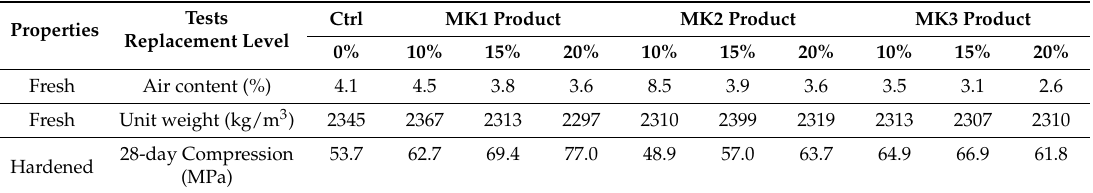
Table 5. Mean, standard deviation, and an outlier of the binary mixture results.